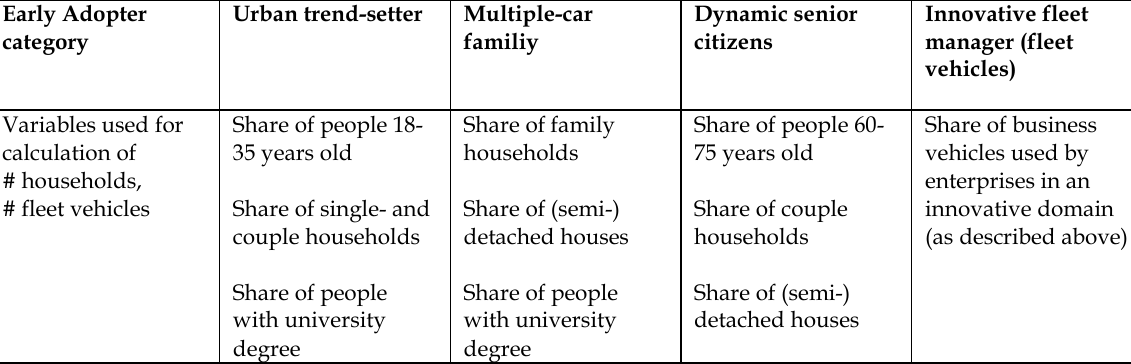
Table 1. Variables used to calculate the number of Early Adopters in the municipalities Early